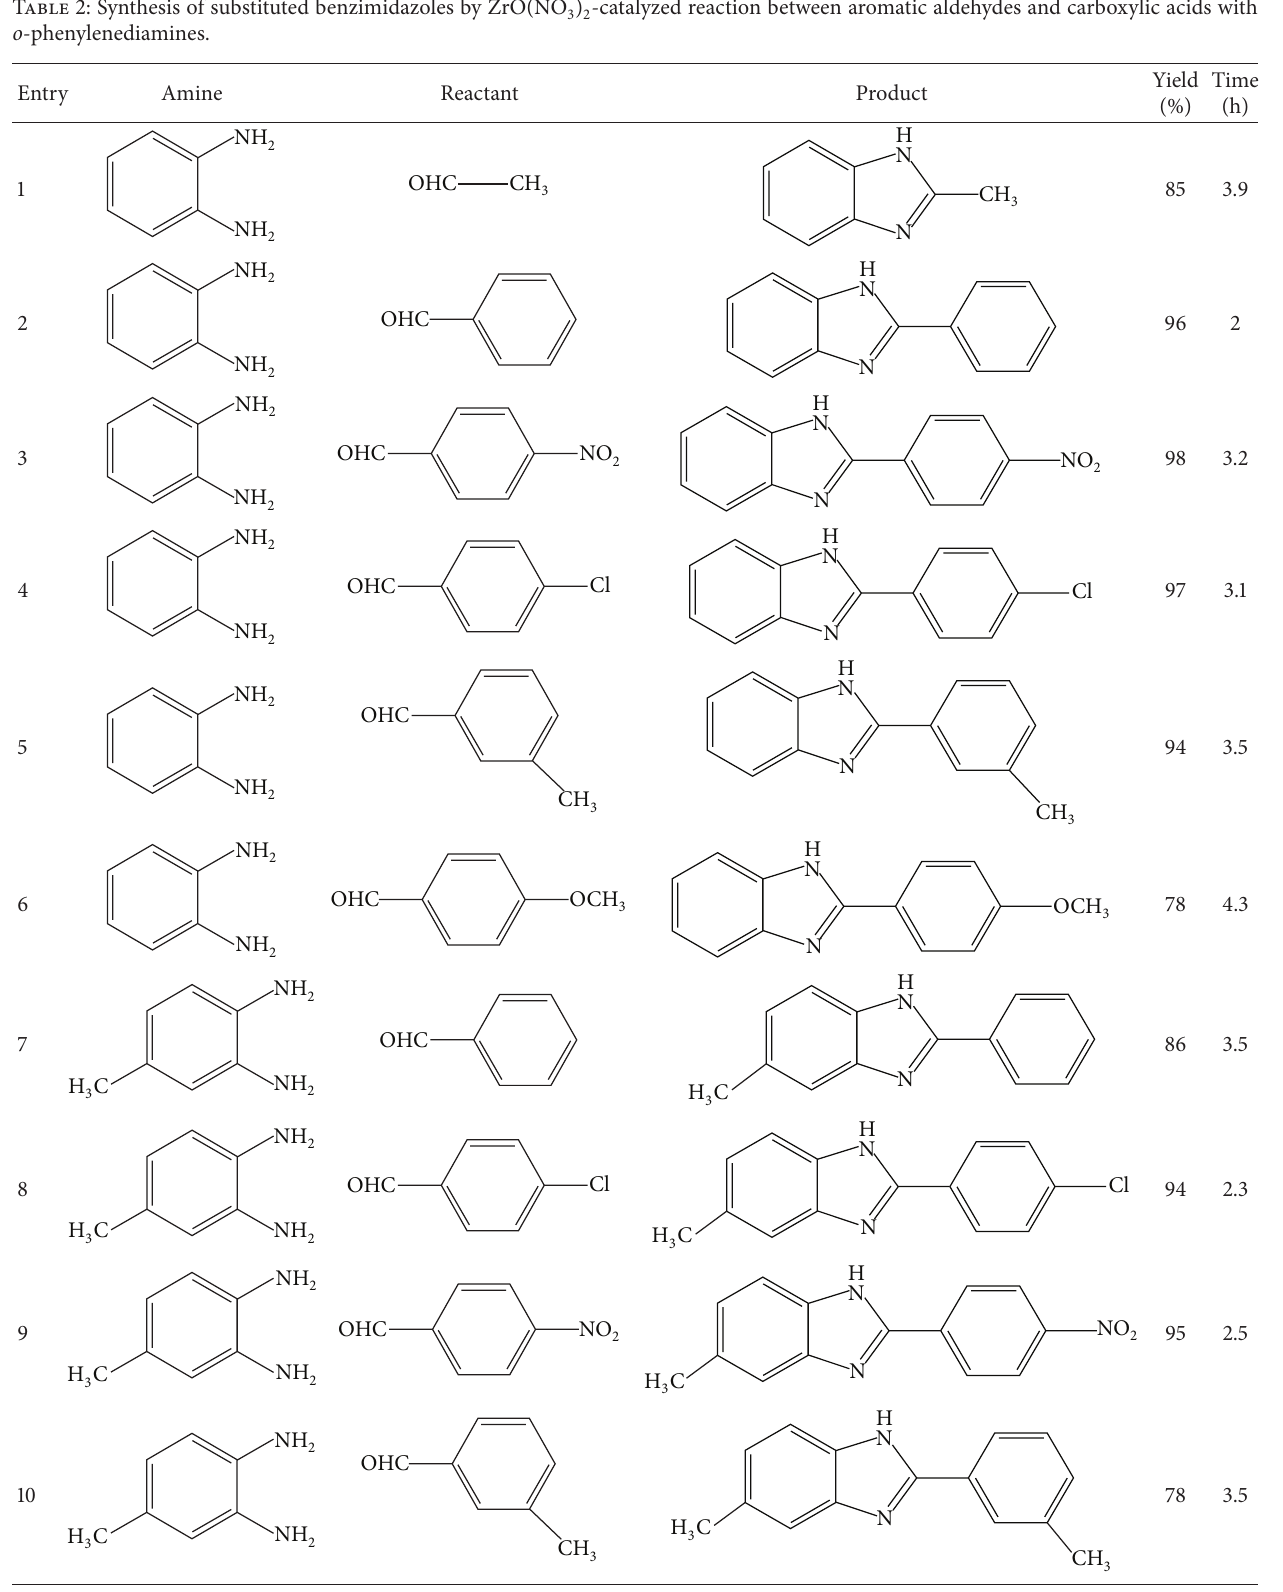
) -catalyzed reaction between aromatic aldehydes and carboxylic acids with 3 2